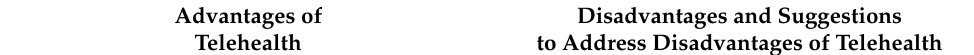
Table 2. Themes of telehealth use: advantages, disadvantages, and suggestions to address disadvantages. Advantages